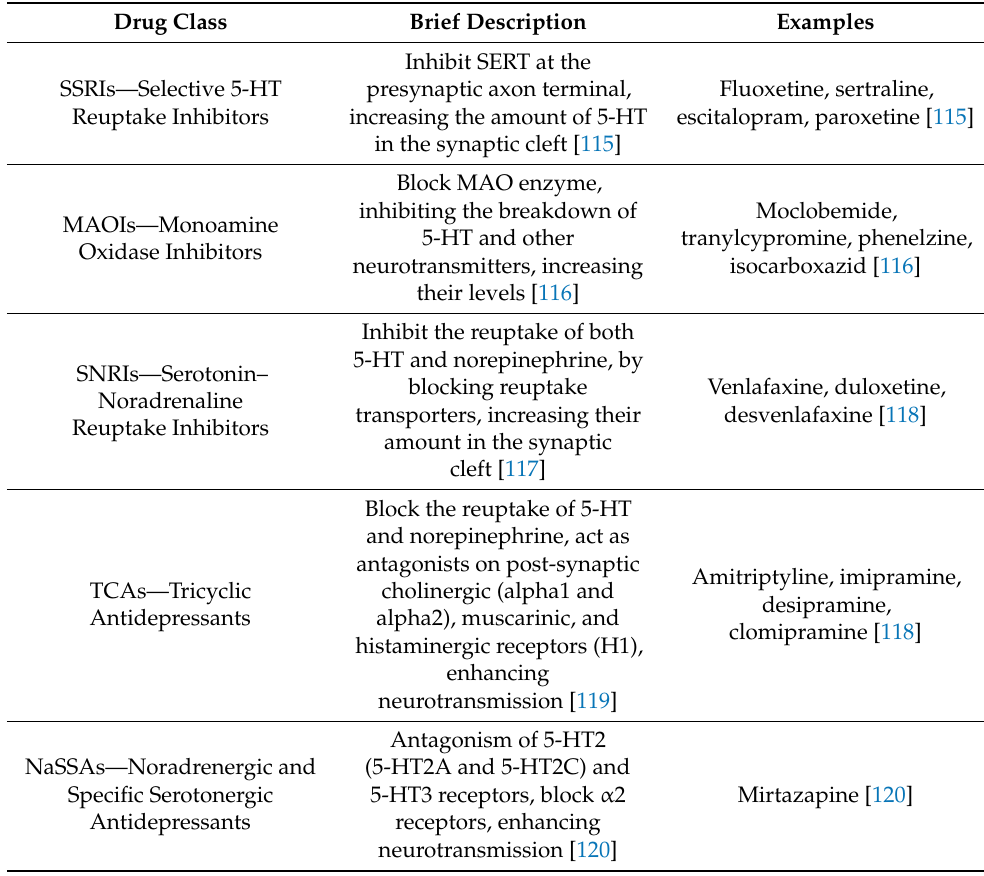
Table 1. Principal drug classes related to 5-HT in the treatment of